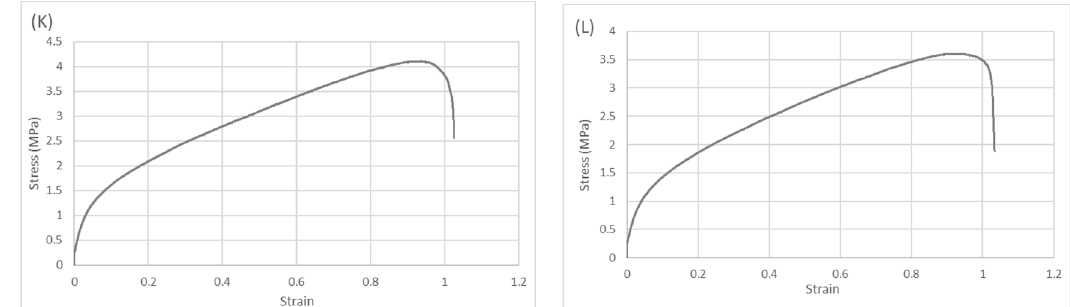
Figure 8. Stress over strain graphs. ( A – D ) = replicates of piscine gelatine bioplastic, ( E – H ) = replicates of porcine gelatine bioplastic, ( I – L ) = replicates of bovine gelatine bioplastic.